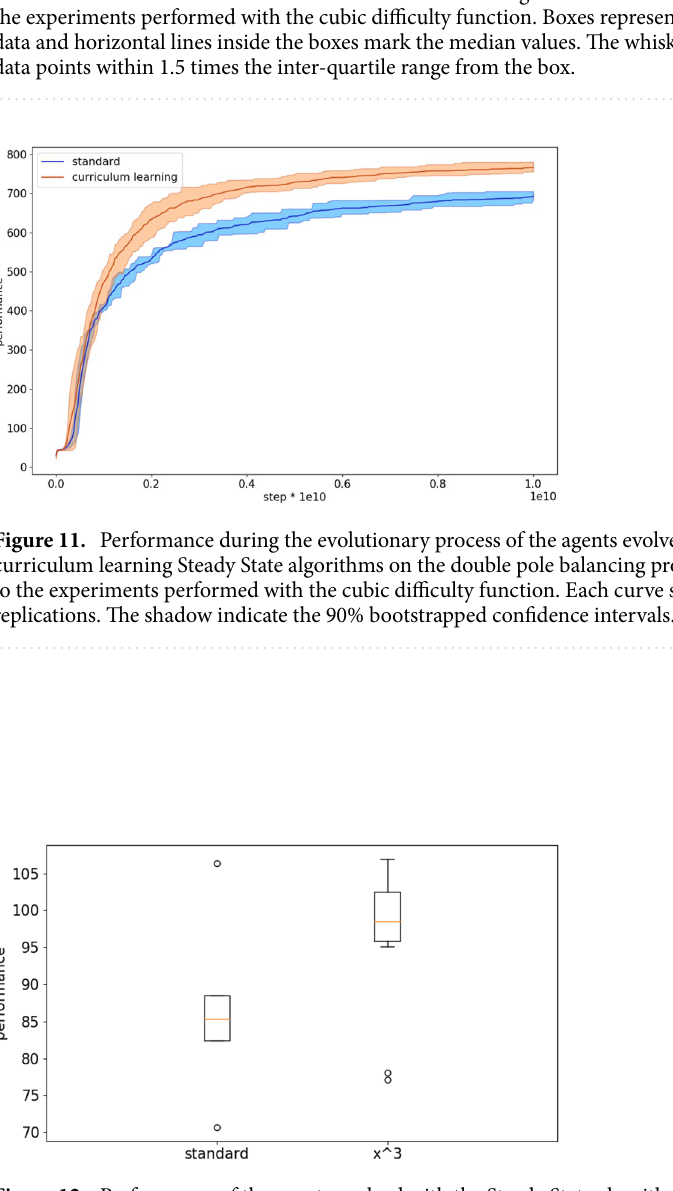
Figure 12. Performance of the agents evolved with the Steady State algorithm on the bipedal hardcore problem with the standard and with the curriculum learning version of the algorithm. The latter data refers to the experiments performed with the cubic difficulty function. Boxes represent the inter-quartile range of the data and horizontal lines inside the boxes mark the median values. The whiskers extend to the most extreme data points within 1.5 times the inter-quartile range from the